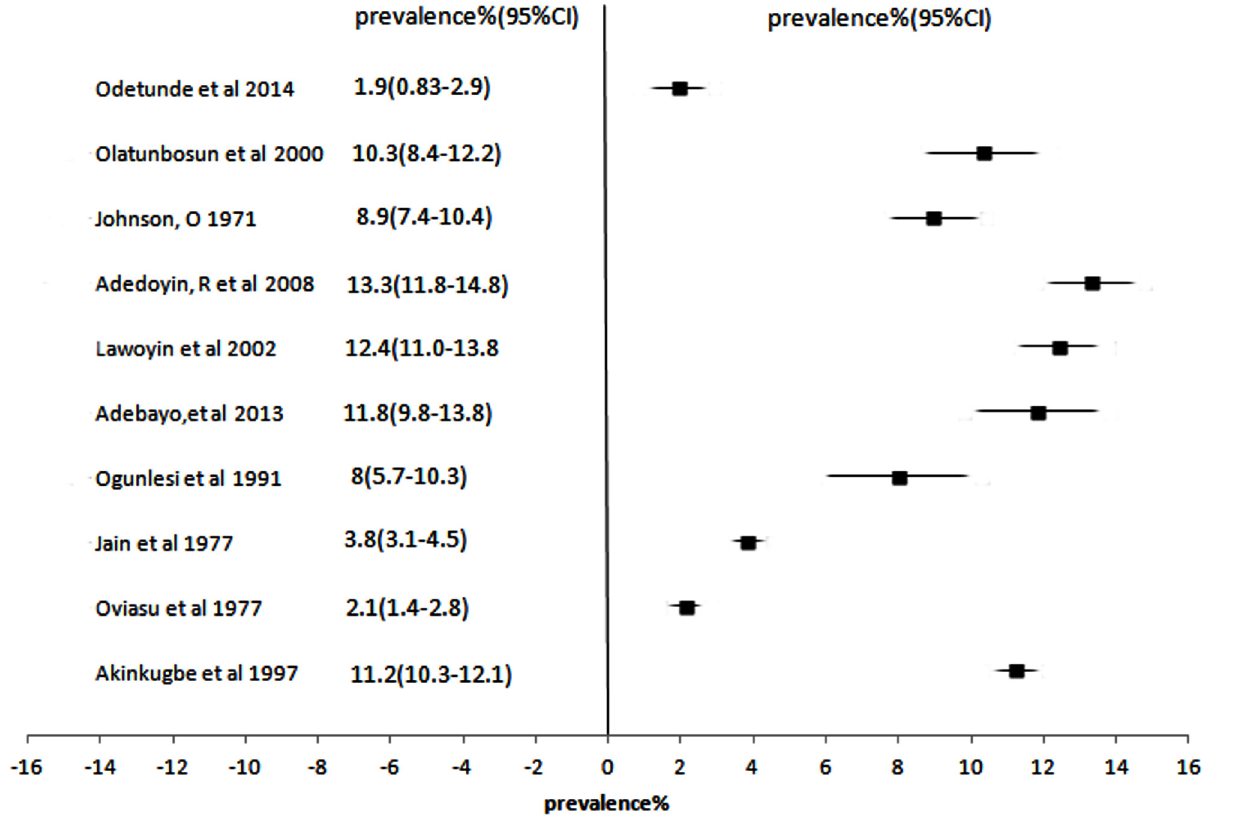
Fig 3. Forest Plot showing prevalence of hypertension% & 95%CI across studies that used BP cut-off (cid:1) 160/90mmHg.